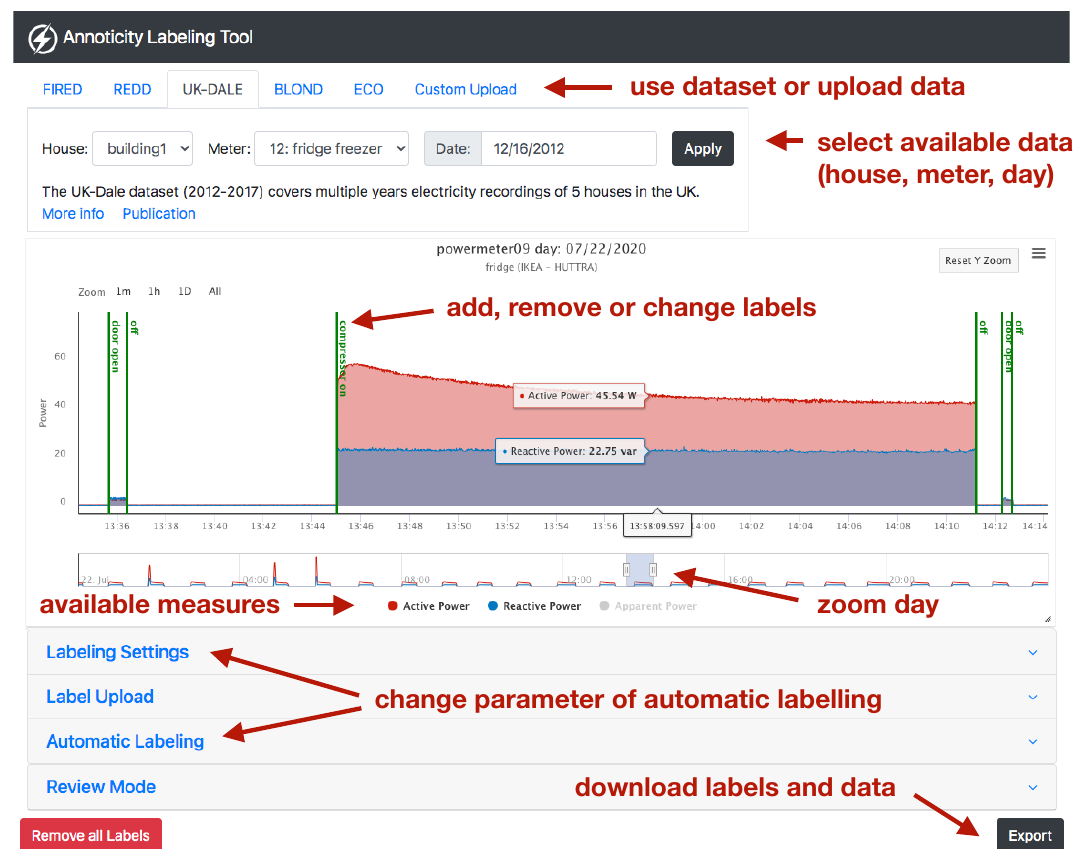
Figure 5. The graphical user interface of the Annoticity inspection and labeling tool. The fridge events were generated and clustered automatically. Each text description ( off , compressor on , and door open ) was only set once by the user. All other occurrences were labeled accordingly (modified from